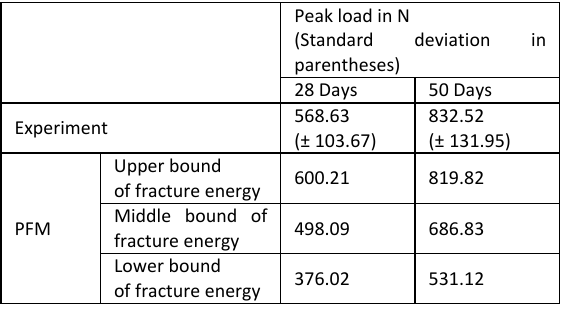
Peak load in N (Standard deviation in